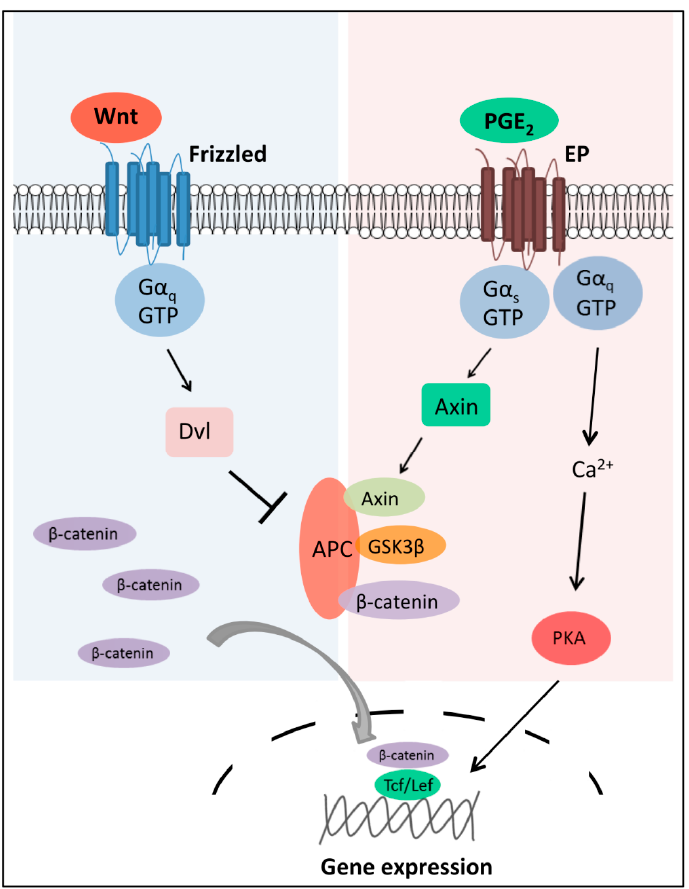
Figure 3. Diversity in GPCR-mediated regulation of Wnt/ β -catenin. Wnt stimulation of the Fzd/ β -catenin pathway activates the phosphoprotein Dvl, leading to inhibition of the β -catenin destruction complex composed of APC, the serine/threonine kinase glycogen synthase kinase 3 β (GSK-3 β ) and Axin [116,117]. Cytoplasmic β -catenin then translocates to the nucleus, where it cooperates with the Tcf/Lef transcription factors to modify transcription of a set of Wnt target genes, primarily cell cycle regulators [53]. EP, a GPCR, utilizes distinct mechanisms to regulate β -catenin expression in cancer. EP promotes cancer cell growth by modulating a Ga s -Axin- β -catenin signaling axis [114]. Binding of the PGE 2 agonist activates G α s , which binds to Axin displacing APC from the destruction complex leading to stabilization and translocation of active β -catenin [56]. The diversity of GPCR signaling allows cancer cells to harness varying mechanisms to control key oncogenic targets. ↓ : signaling activation; ⊥ : signaling inhibition; grey curved arrow indicates translocation; dashed line represents nucleus.